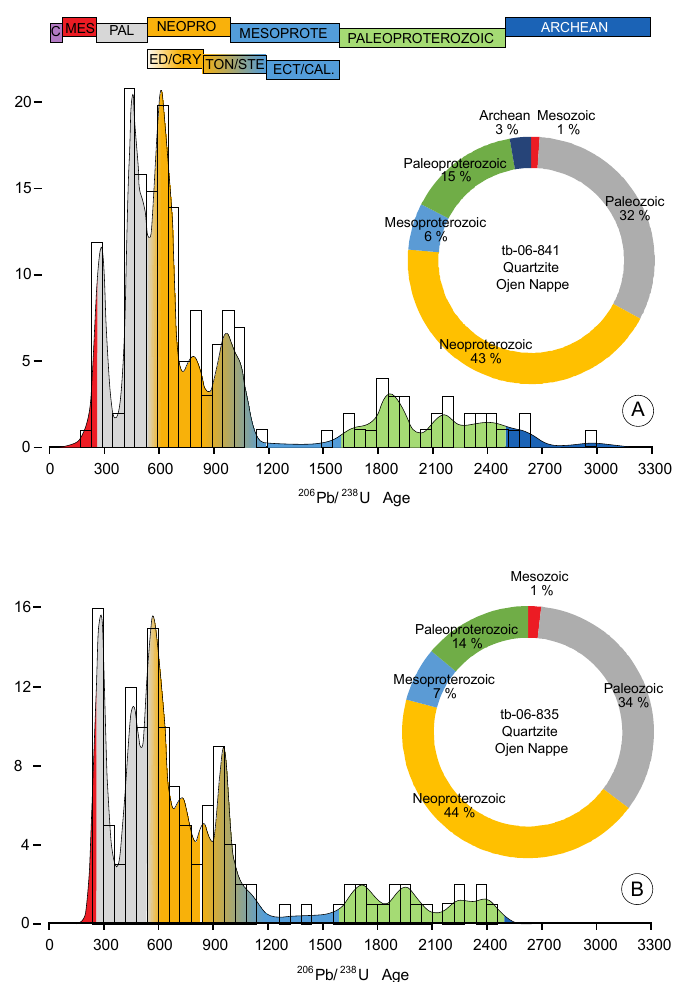
Figure 4. Kernel density estimation (KDE), histograms, and pie-chart age distribution plots of analyzed zircons of Ojén’s samples: ( A ) tb-06-841 and ( B ) tb-06-835.